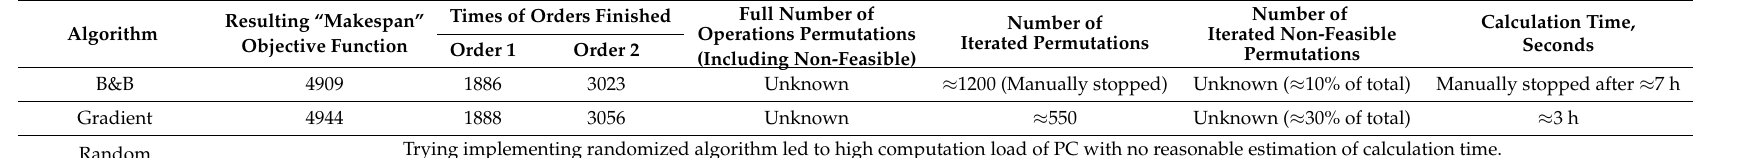
Table 3. Algorithms test results: increased number of operations (500